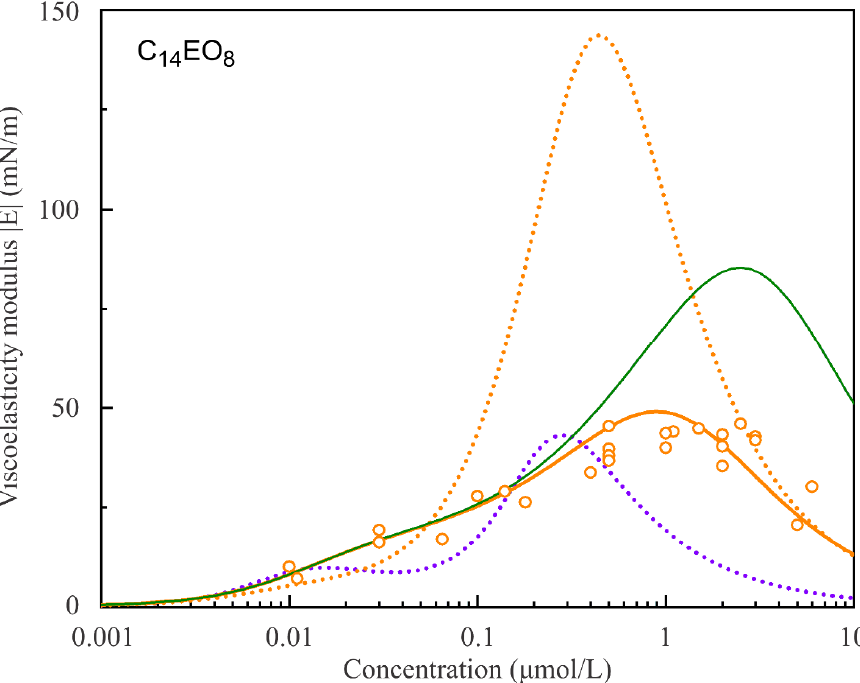
Figure 9. Experimental values of the surface dilational visco-elasticity modulus |E| for C 14 EO 8 solutions of different concentrations measured for the fixed frequency 0.1 Hz (symbols). Theoretical curves are calculated assuming various number of states (orange dotted line for s = 2 and orange solid line for s = 10) with the parameter sets listed in Table 2 and the diffusion coefficient D = 8.7 ∙ 10 − 9 m 2 /s. For comparison, theoretical curves for different diffusion coefficients and the same other parameters are also presented: D = 2 ∙ 10 − 7 m 2 /s (violet dotted line for s = 2) and D = 5 ∙ 10 − 10 m 2 /s (green solid line for s = 10). For details, see text.